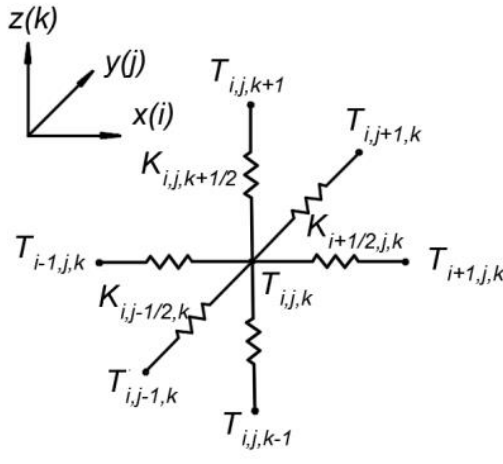
Figure 7. Thermal conductance connected to cell ( i ; j ; k ) [38].